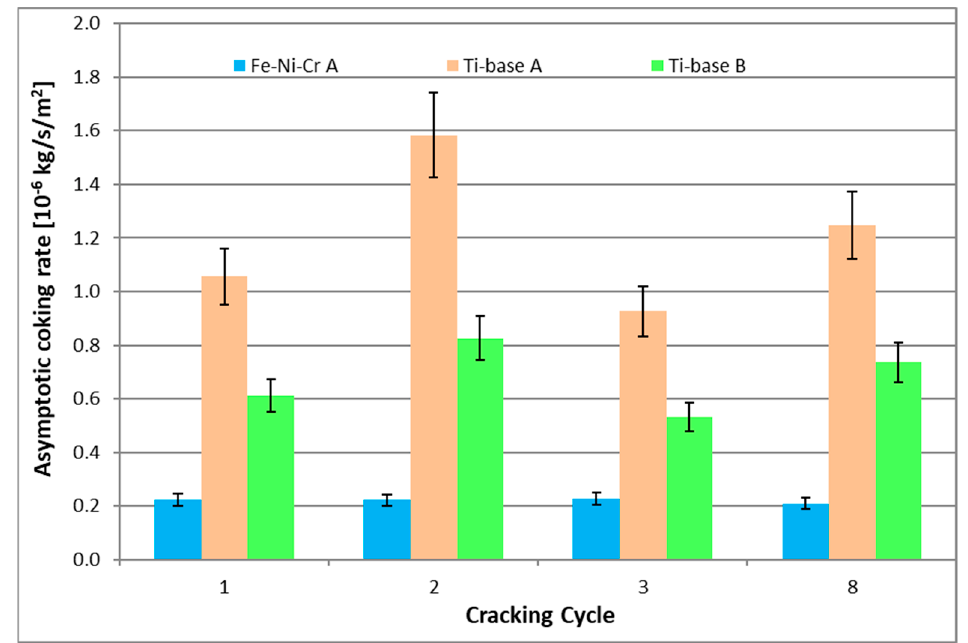
Figure 3. Calculated asymptotic coking rates for the reference 25 / 35 Cr / Ni and Ti–base alloy. Ethane steam cracking: F HC = 29.18 × 10 − 6 kg s − 1 , δ = 0.33 kg H2O kg − 1 HC, T reactor = 1173.15 K, P = 101.35 kPa, F H2O = 9.72 × 10 − 6 kg · s − 1 .